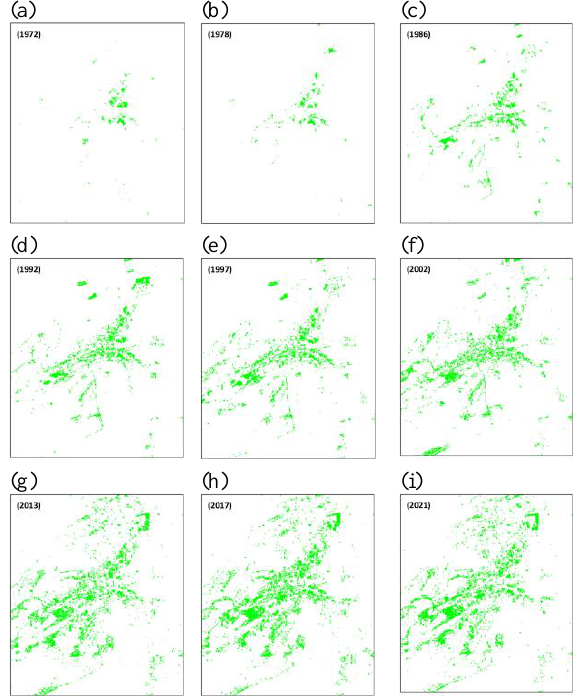
Figure 4. Vegetation cover changes in Al-Ain during the study period (a) 1972, (b) 1978, (c) 1986, (d) 1992, (e) 1997, (f) 2002, (g) 2013, (h) 2017, and (i)